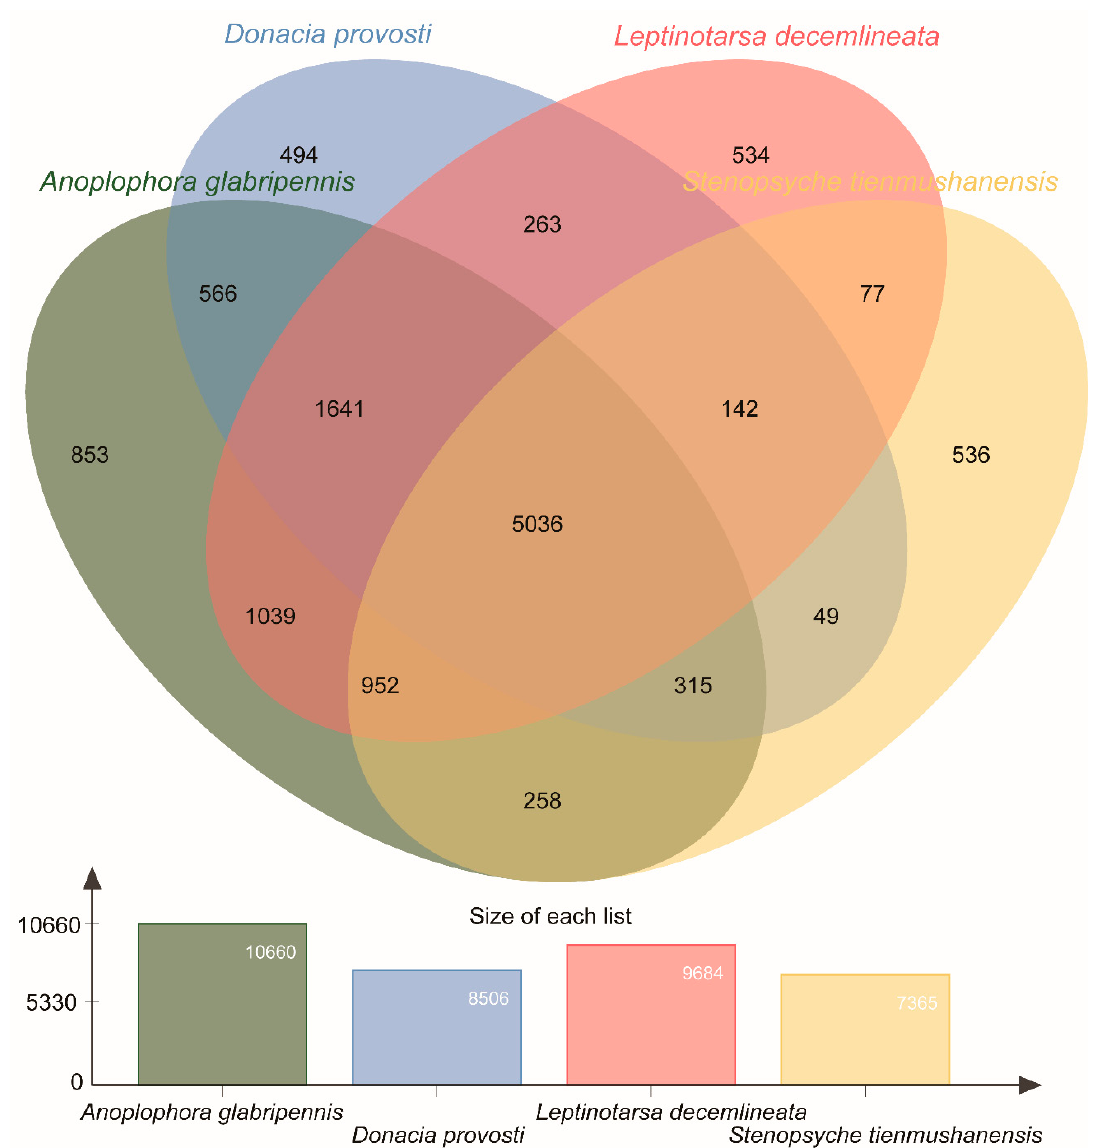
Figure 3. Venn diagram of gene homology among the four species annotations and number of gene homology in the four species annotations.